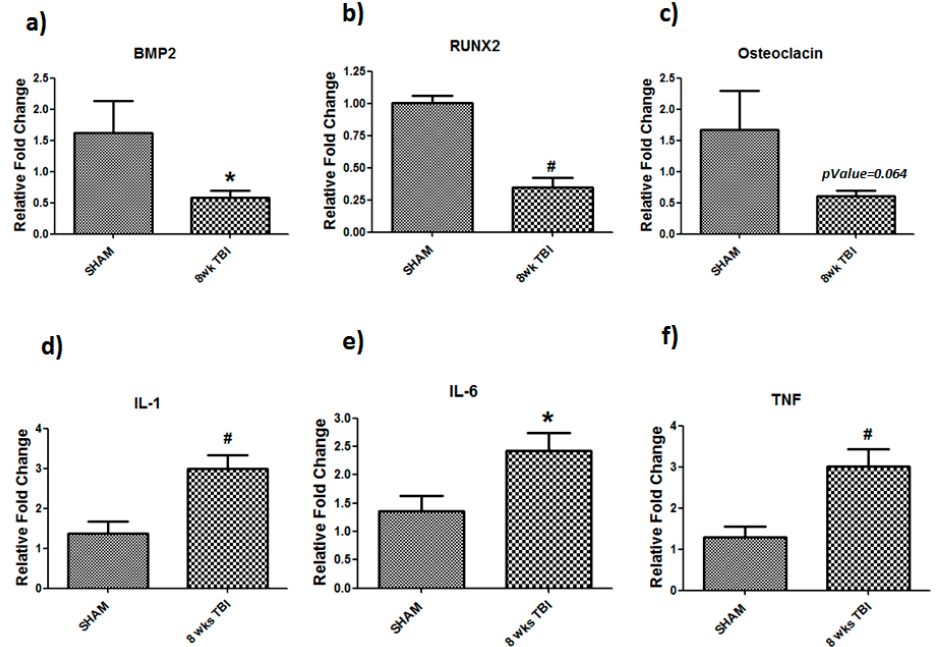
Figure 2. Effects of TBI on bone structural quality of femur measured by micro-computed tomography ( µ CT). ( a ) BMD, ( b ) bone volume, ( c ) tubercular thickness, ( d ) tubercular number were significantly